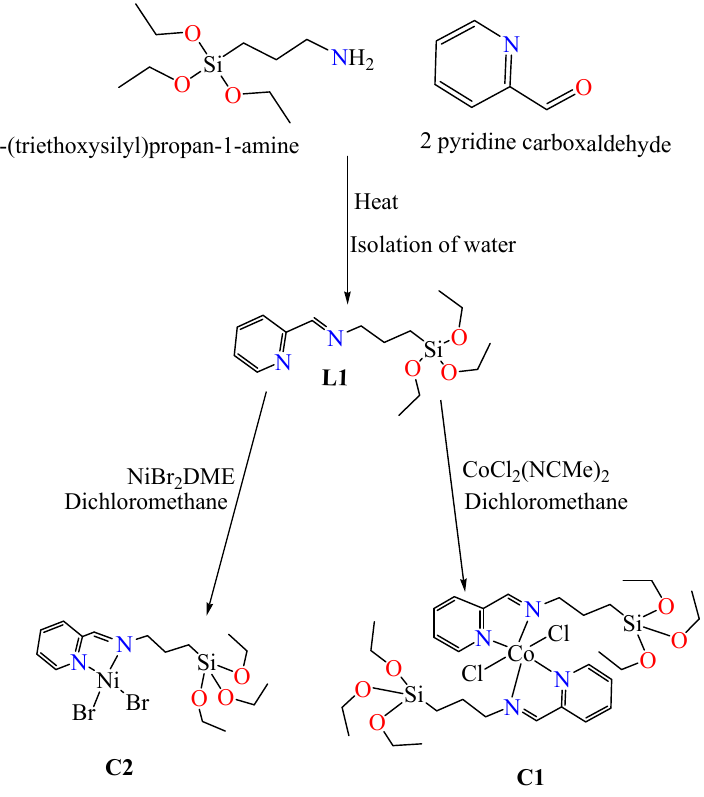
Scheme 1 . Synthesis of L1 and complexes C1 and C2 . Scheme 1. Synthesis of L1 and complexes C1 and C2